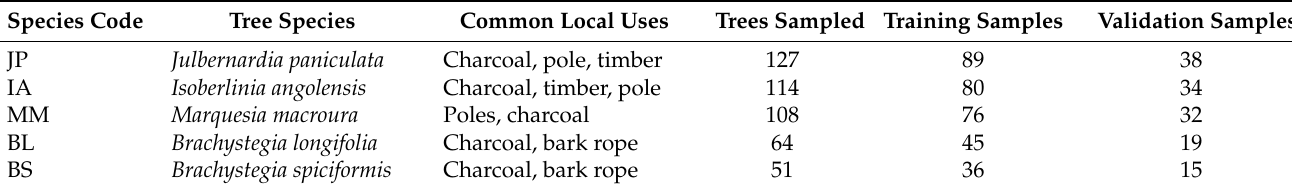
Table 1. Sampled dominant tree species in the area.